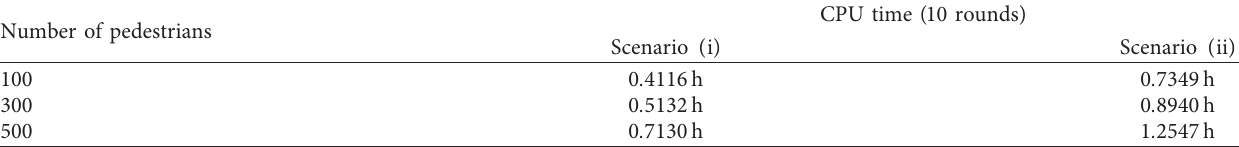
Table 2: The computation time of ten trial runs in scenario ( i ) and in scenario ( ii ) with 100, 300, and 500 evacuees. Number of pedestrians